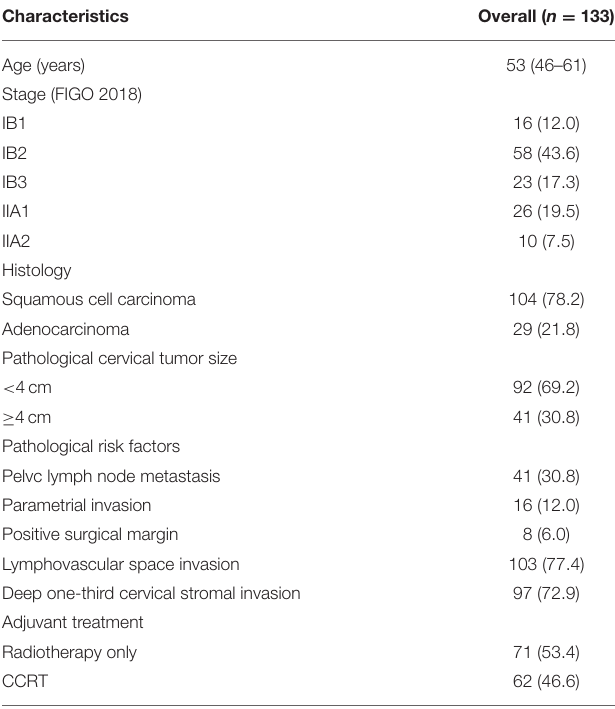
TABLE 1 | Patient and tumor